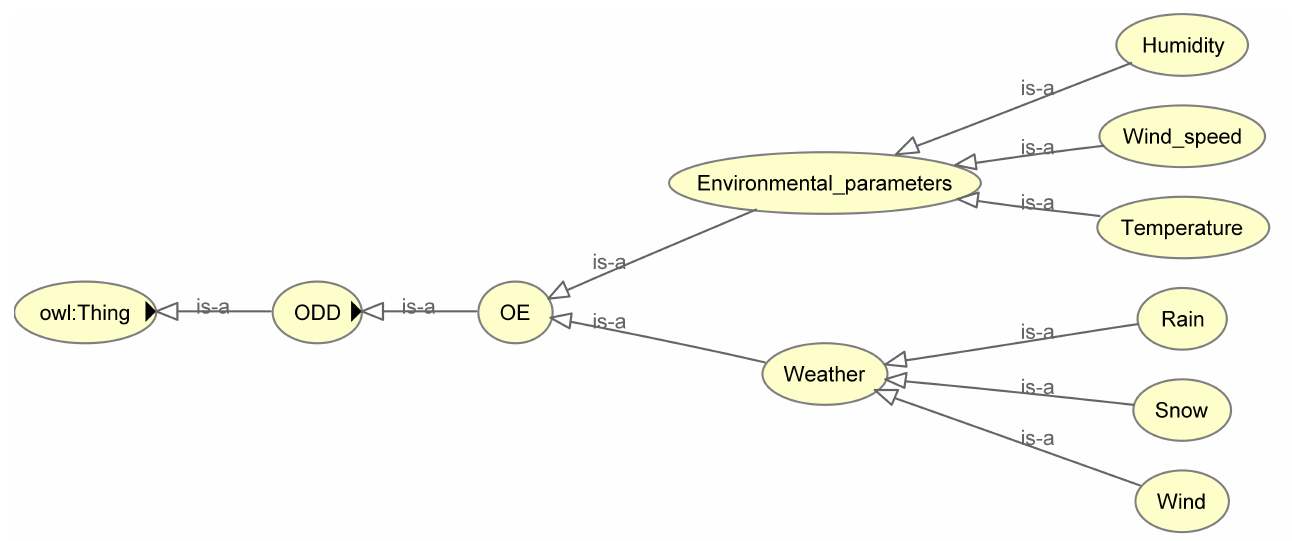
Figure 10. Structure diagram of the operating